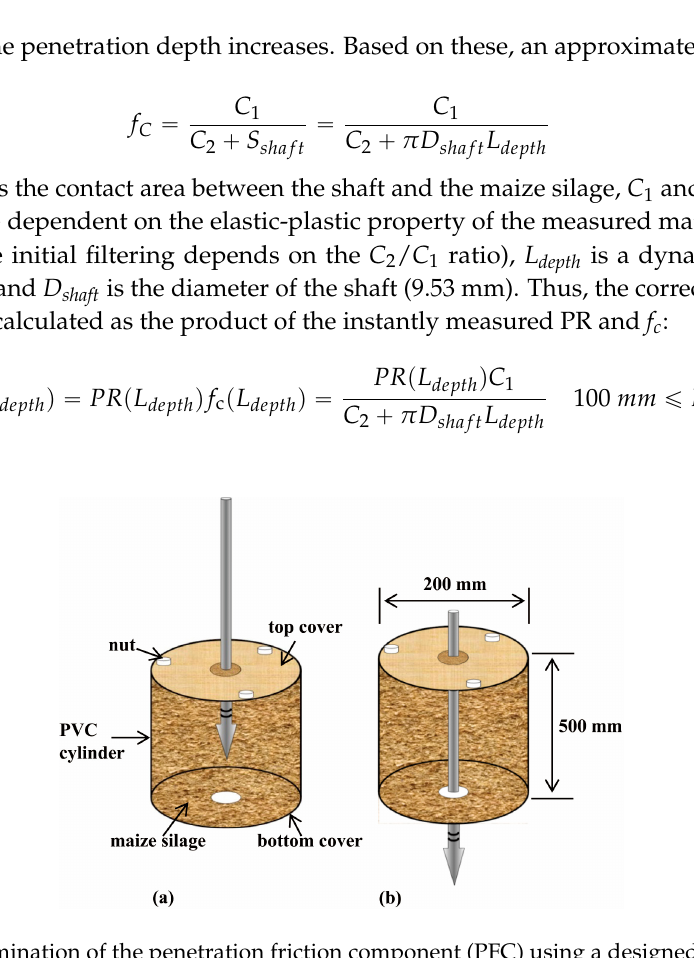
Figure 6. Determination of the penetration friction component (PFC) using a designed cylinder with two covers, each having a hole at the center. ( a ) the measurement for penetration resistance (PR) and, ( b ) the measurement for determining the penetration friction component (PFC).